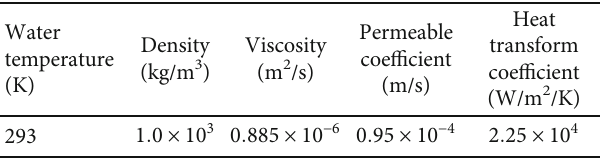
Table 2: Calculation parameters of the numerical model without considering hydraulic-thermal